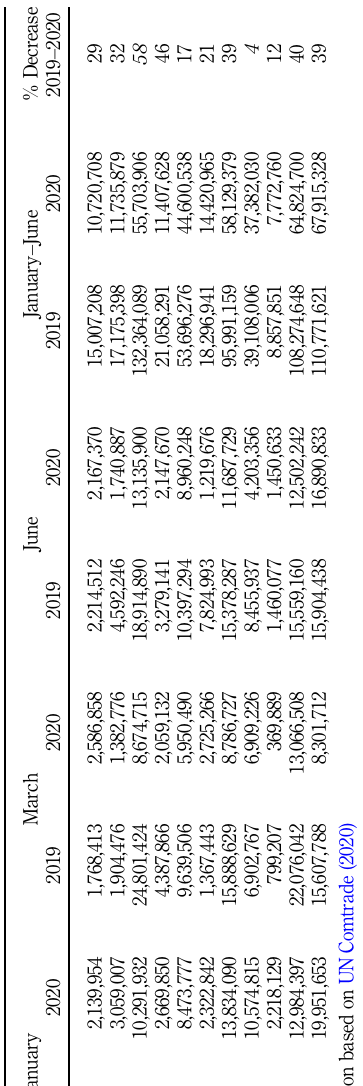
Table 1. Export trade value (US$) of main trading partners for the